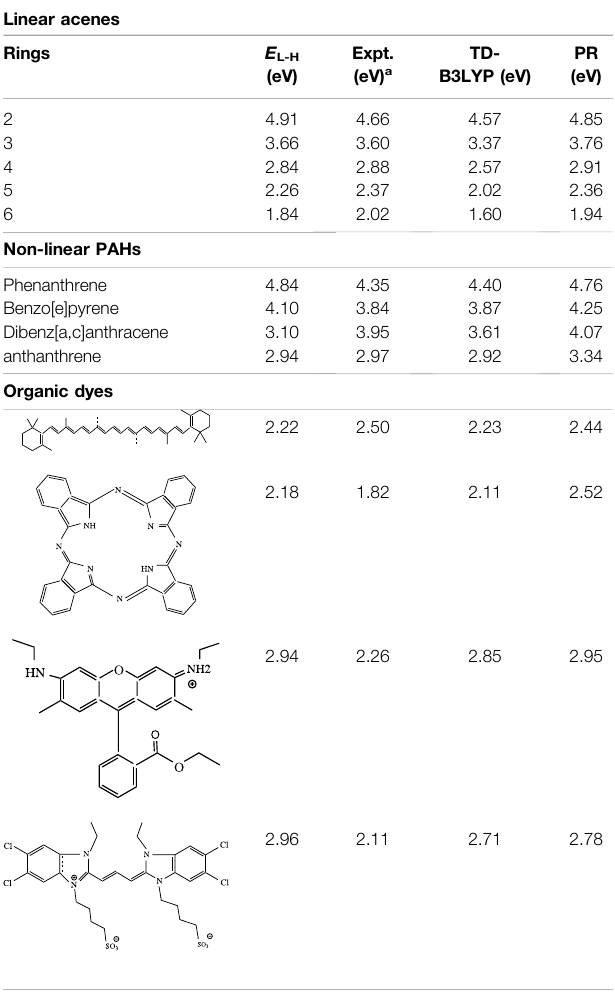
a Experimental values are obtained from Grimme and Parac (2003) for linear acenes, Parac and Grimme (2003) for non-linear PAHs, and Kowalczyk et al. (2011) for organic